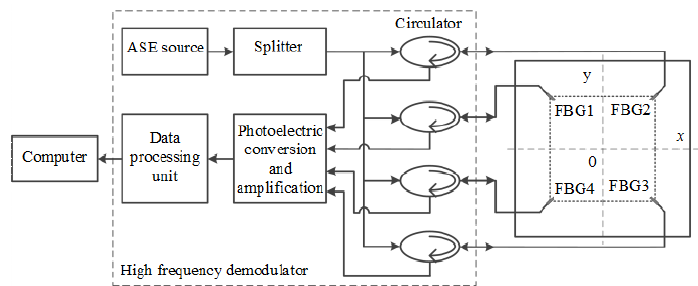
Fig. 1 Diagram of the FBG high frequency demodulation system.